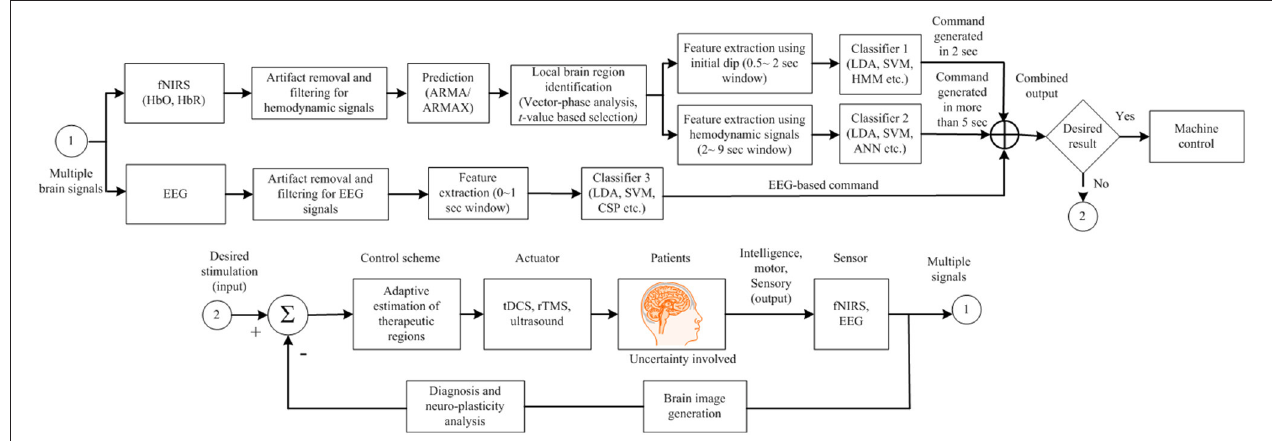
FIGURE 9 | Proposed brain-computer interface (BCI) scheme to improve the BCI performance for device control for locked-in syndrome patients.